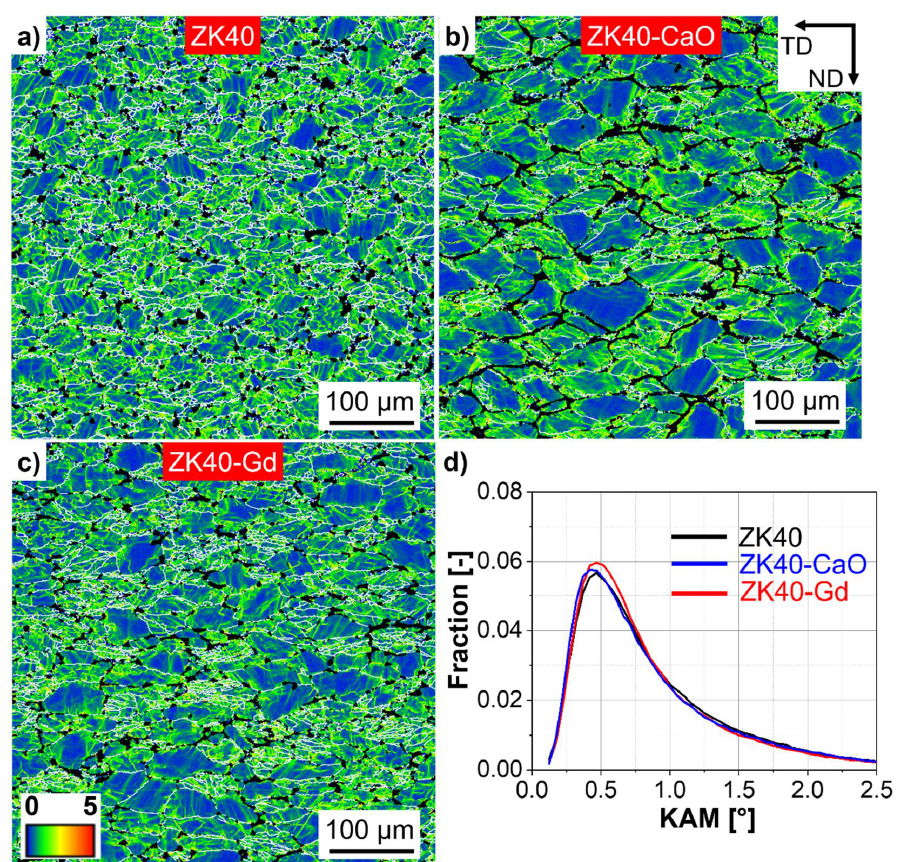
Figure 10. Kernel average misorientation maps for the alloys deformed at 300 °C and 0.001 s −1 : ( a ) ZK40, ( b ) ZK40-CaO and ( c ) ZK40-Gd. Kernel average misorientation distributions for the three alloys showed in ( d ). Only α-Mg is indexed. Non-indexed regions are highly deformed regions or intermetallic compounds. White lines indicate high angle grain boundaries. ND and TD indicate the compression and transversal directions, respectively.